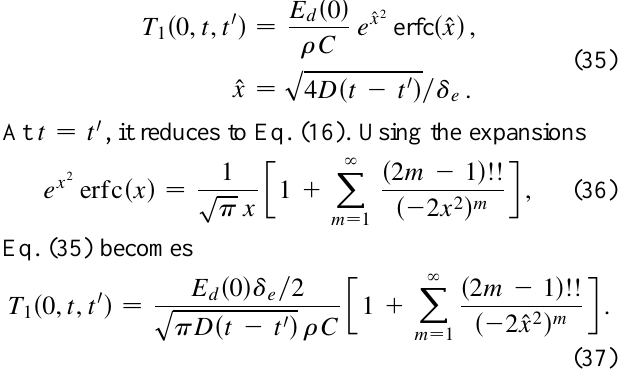
TABLE I. Electron pulse heating from image current Single bunch Multibunch heating Temp